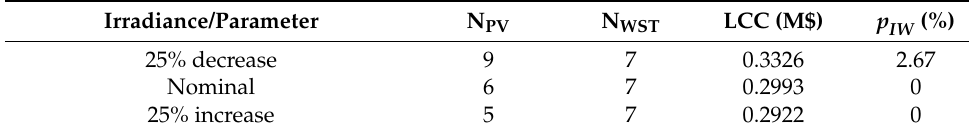
Table 13. Effect of changes in PV radiation intensity on system optimization.